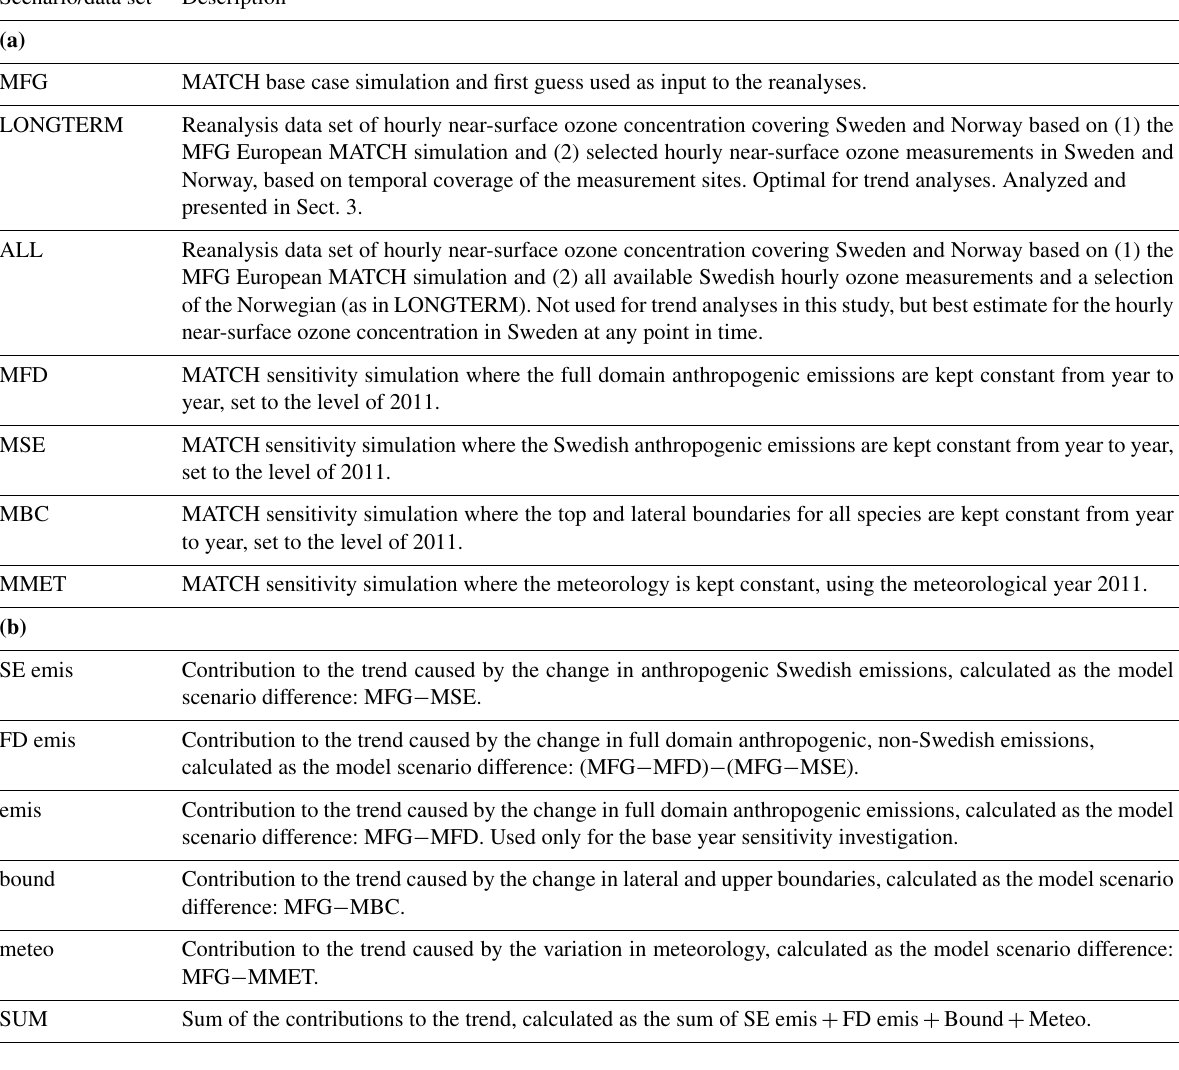
Table 1. (a) Model calculations and scenarios, all covering the years 1990–2013, including the first guess to the retrospective variational data analysis and base case to the sensitivity simulations (MFG), two reanalysis data sets (LONGTERM and ALL) and sensitivity scenarios (MFD, MSE, MBC and MMET). (b) Formation of contributions to the linear trend over the period 1990–2013 from the sensitivity simulations (a)